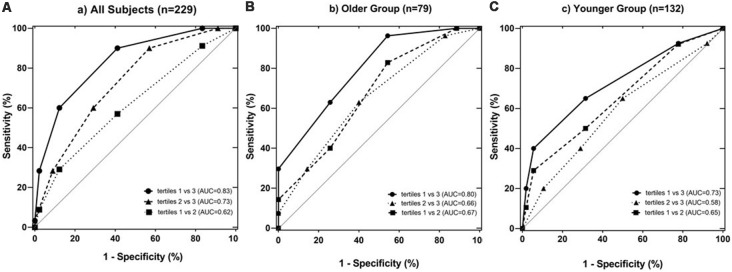
Receiver operating characteristic (ROC) analysis testing the identification of individuals with different levels of brain structural changes based on the tertiled BALI scores, by the number of CVRF per se. Analyses were performed for all subjects in the sample (A; n = 229), and separately for the stratified older (B; n = 97; age ≥ 50 years) and younger (C; n = 132; age < 50 years) groups. The differentiation performance was estimated using the area under the ROC curve (AUC). The lower and upper bounds and level of significance were also provided for (A–C; see below). In each sub-figure, square and dotted line: tertiles 1 vs. 2; circles and solid line: tertiles 1 vs. 3; triangles and dashed line: tertiles 2 vs. 3; the gray diagonal line: indicator of AUC = 0.50.